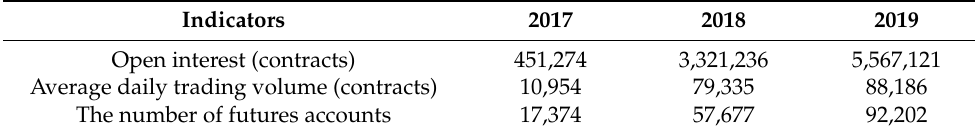
Table 3. VN30-Index futures contract trading metrics (2017–2019).